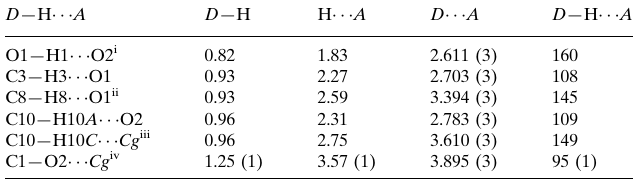
Hydrogen-bond geometry (A˚ , (cid:2) ). Cg is the centroid of the C4–C9 benzene